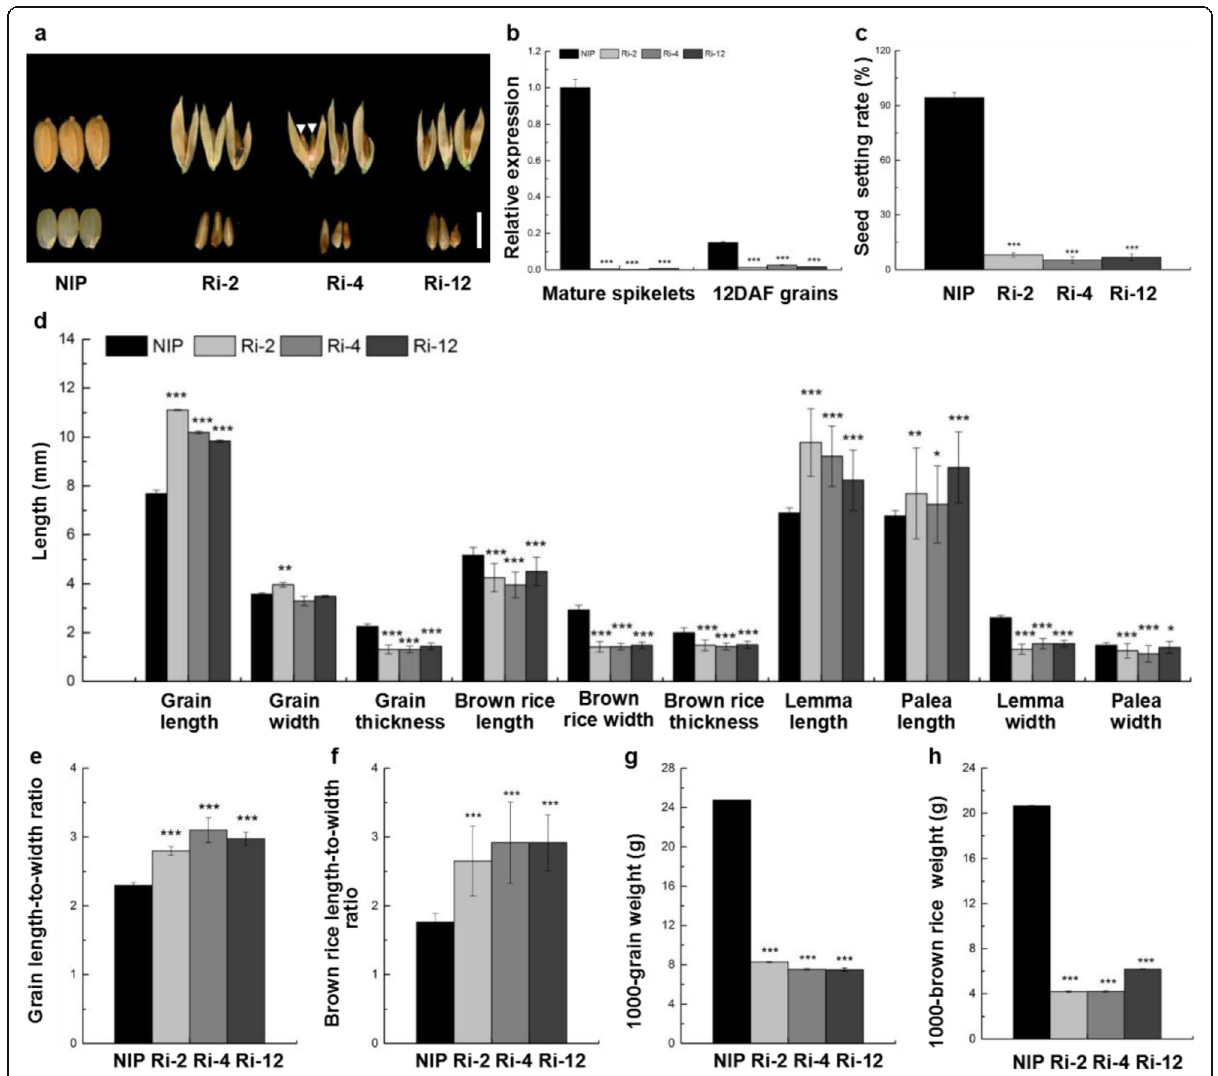
Fig. 9 Oat-like rice phenotypes and statistics of OsMADS1 -RNAi plants. a Grain shape and phenotypes of severe OsMADS1 -RNAi plants (Ri-2, Ri-4 and Ri-12) with similar Oat-like rice phenotypes in comparison with grains of wild-type plant (NIP). Arrowheads indicate conjugated twin brown rice. b Relative expression of OsMADS1 in matures spikelets and 12 DAF grains of wild-type and severe OsMADS1 -RNAi plants. c Seed setting rate of wild-type and severe OsMADS1 -RNAi plants. d Comparison of grain length, grain width, grain thickness, brown rice length, brown rice width, brown rice thickness, lemma length, palea length, lemma width and palea width between wild-type and severe OsMADS1 -RNAi plants. e-h Comparison of grain length-to-width ratio ( e ), brown rice length-to-width ratio ( f ), 1000-grain weigh ( g ) and 1000-brown rice weight ( h ) between wild-type and severe OsMADS1 -RNAi plants. Bar: ( a ) 5 mm. Data presented are mean values ± SDs [ n = 3 repeats in b , g and h ; n = 12 repeats in c ; n = 50 in d-f .]. Student ’ s t -test: * p < 0.05, ** p < 0.01, *** p <